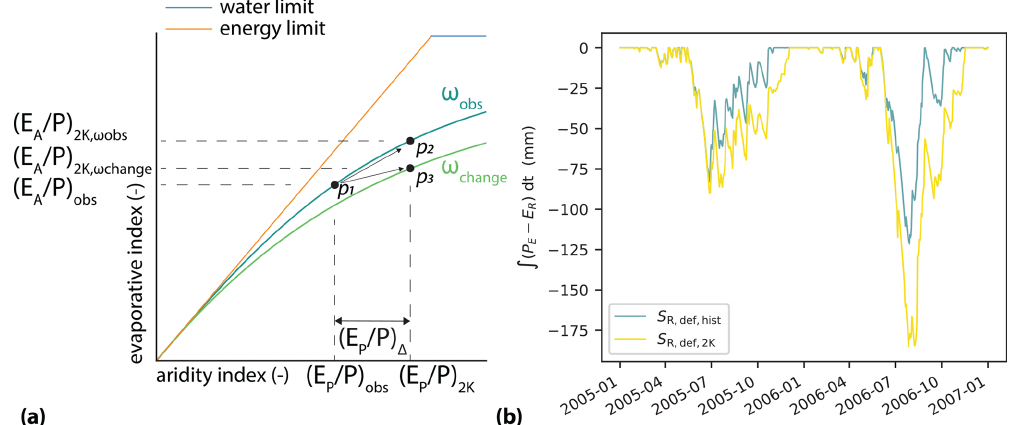
Figure 3. (a) Representation of the Budyko space, which shows the evaporative index ( E A /P = 1 − Q/P ) as a function of the aridity index ( E P /P ) and the water and energy limit. A catchment with the aridity index (E P /P) obs and evaporative index (E A /P) obs , which is derived from observed historical data assuming (E A /P) obs = 1 − (Q/P) obs , plots at location p 1 on the parametric Budyko curve with ω obs . A movement in the Budyko space towards p 2 along the ω obs curve is shown as a result of a change in the aridity index (E P /P) (cid:49) towards a projected (E A /P) 2K ,ω obs associated with aridity (E P /P) 2K . An additional shift from the ω obs curve towards a location p 3 on a ω change curve is assumed if additional factors (e.g., land use) are projected to change besides the aridity index. Here, the represented downward shift in ω reduces the change in evaporative index to (E A /P) 2K ,ω change . (b) Cumulative storage deficits ( S R , def ) derived from effective precipitation ( P E ) and transpiration ( E R ), using the simulated historical and 2K climate data, are shown. Estimates of transpiration ( E R ) are derived from long-term water balance projections as a result of movements within the Budyko framework in response to climate and potential land use